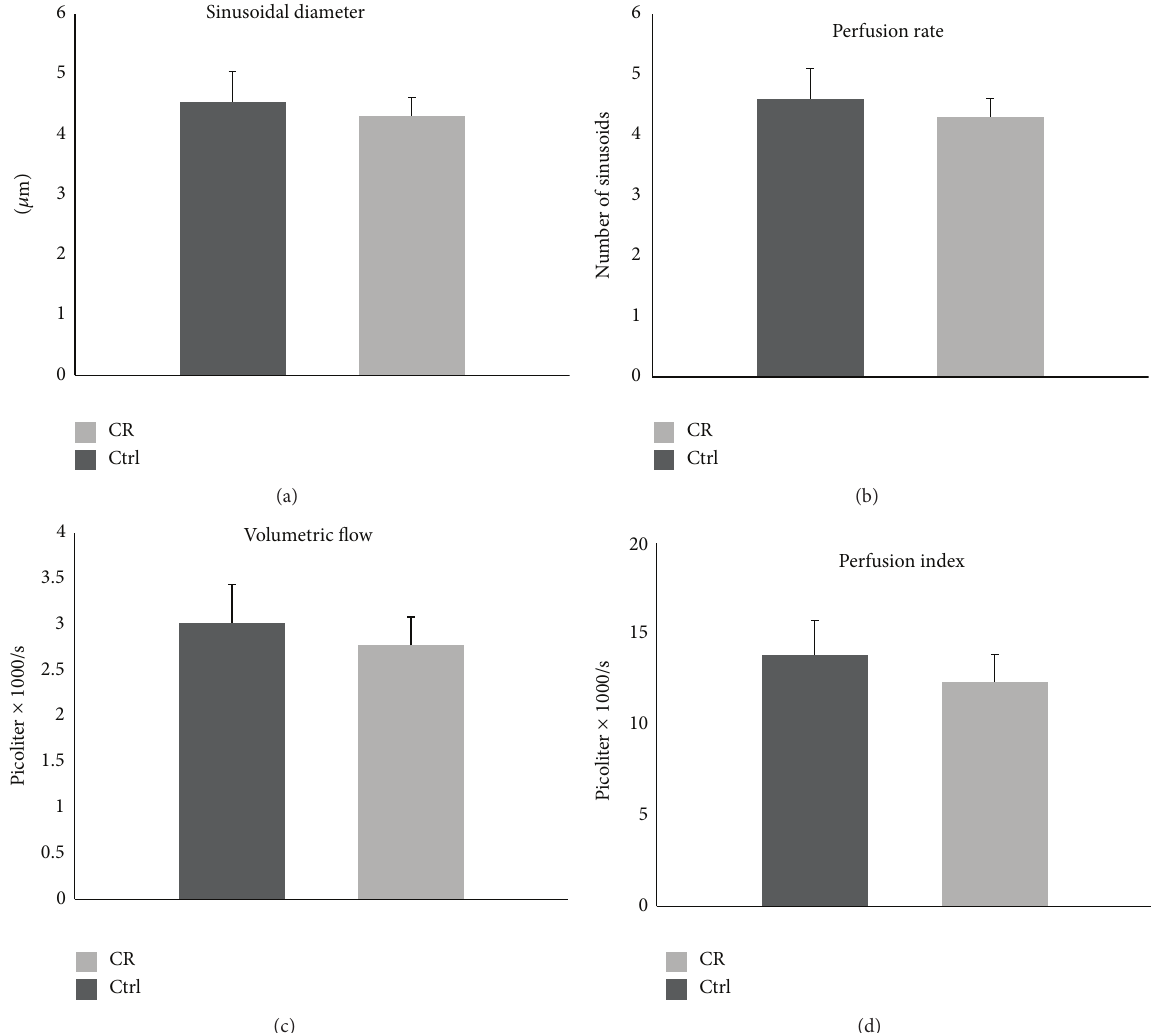
Figure 4: Intravital fluorescence microscopic examination of sinusoids of calorically restricted mice (CR) and control mice (Ctrl). Between the CR mice ( 𝑁 = 7 ) and NR mice ( 𝑁 = 7 ), there were so significant differences in the diameter of sinusoids (a), the perfusion rate expressed as the number of perfused sinusoids per field (b), the volumetric flows (c), and the perfusion index (d). Bars represent mean ± SEM. The mice were 14 months